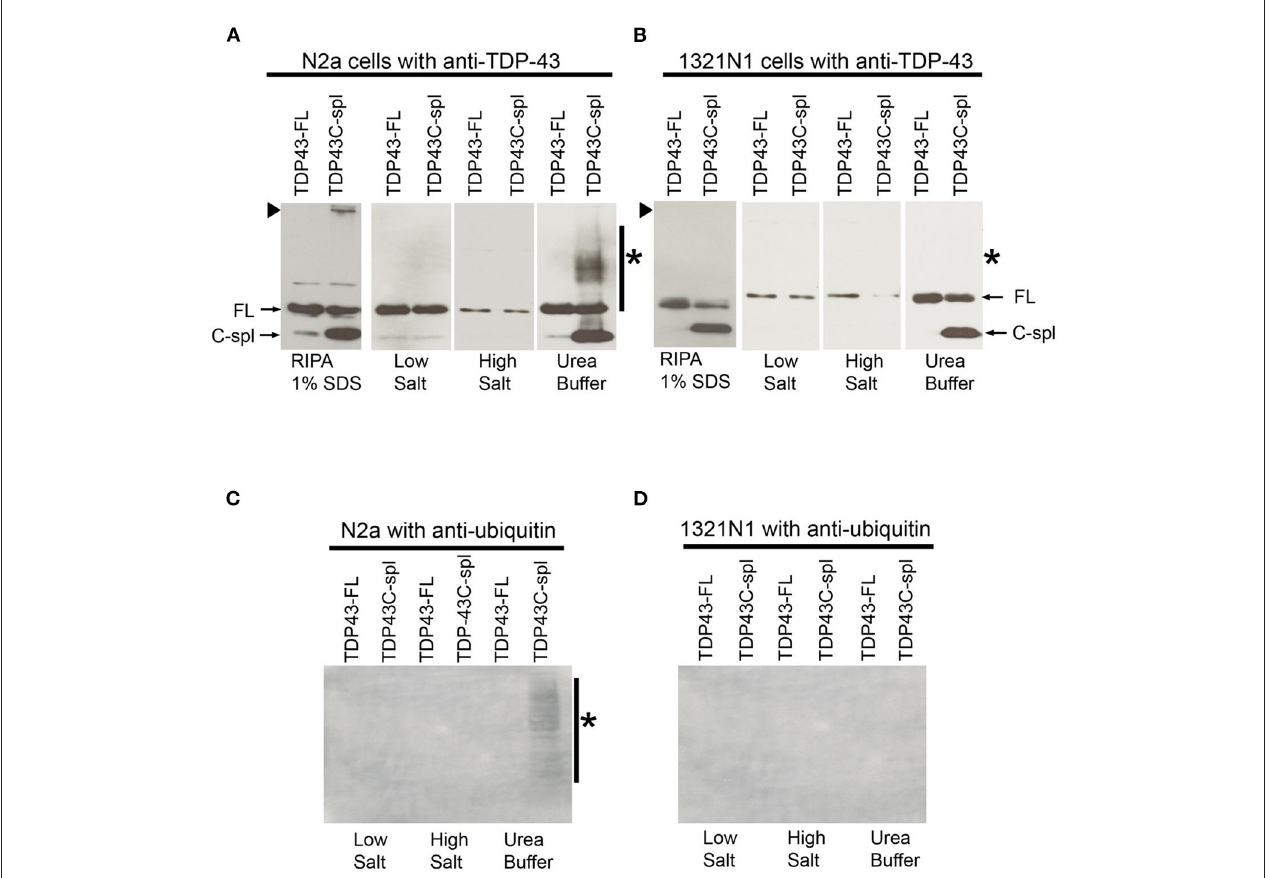
FIGURE 7 | Comparative biochemical analysis of TDP43-FL and TDP43C-spl expressed in N2a and 1321N1 cells. Western blots probed with TDP-43 polyclonal antibody of lysates from N2a cells (A) or 1321N1 cells (B) expressing TDP43-FL or TDP43C-spl. Bands of 43 kDa correspond to TDP43-FL (FL, indicated by arrow) are detected in all fractions. In TDP43C-spl expressing cells, there was clear expression of the 30 kDa C-spl variant. Bands of ∼ 30 kDa in the N2a cell lysate, but not in the 1321N1 cells, may correspond to endogenous TDP43C-spl (C-spl, indicated by arrow). There is high molecular weight TDP-43 immunoreactive material trapped at the gel interface of N2a cells expressing TDP43C-spl, but not the 1321N1 cells [indicated by arrowhead in (A,B) ]. The TDP43C-spl partitioned to the urea soluble fraction. High molecular weight material at the gel interface found in the RIPA soluble fraction of N2a cells expressing TDP43C-spl, is no longer apparent and is replaced by a high molecular weight smear (indicated by asterisk in “Urea Buffer”). This smear was absent in the urea soluble fractions from 1321N1 cells expressing TDP43-Cspl. Western blots of samples in (A,B) probed with antibody to ubiquitin (C, N2a cells and D, 1321N1 cells). High molecular weight smear shown in the urea soluble fraction of N2a cells expressing TDP43C-spl (A) is labeled by ubiquitin antibody in (C) (shown by asterisk), with no labeling of any of the samples derived from 1321N1 cells (D)